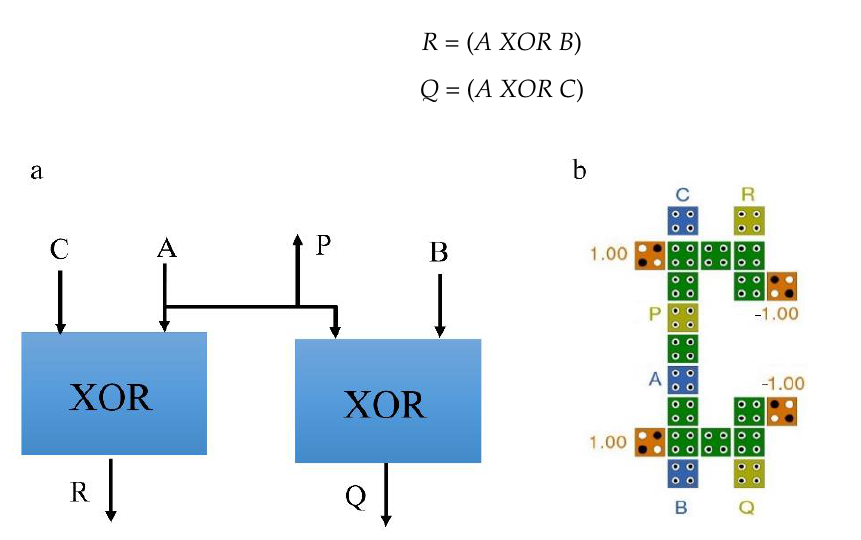
Figure 4. The QCA schematic layout of a 3 × 3 reversible circuit. Figure 4. ( a ) The schematic of the proposed 3 × 3 reversible circuit, ( b ) The QCA layout of the proposed 3 × 3 reversible